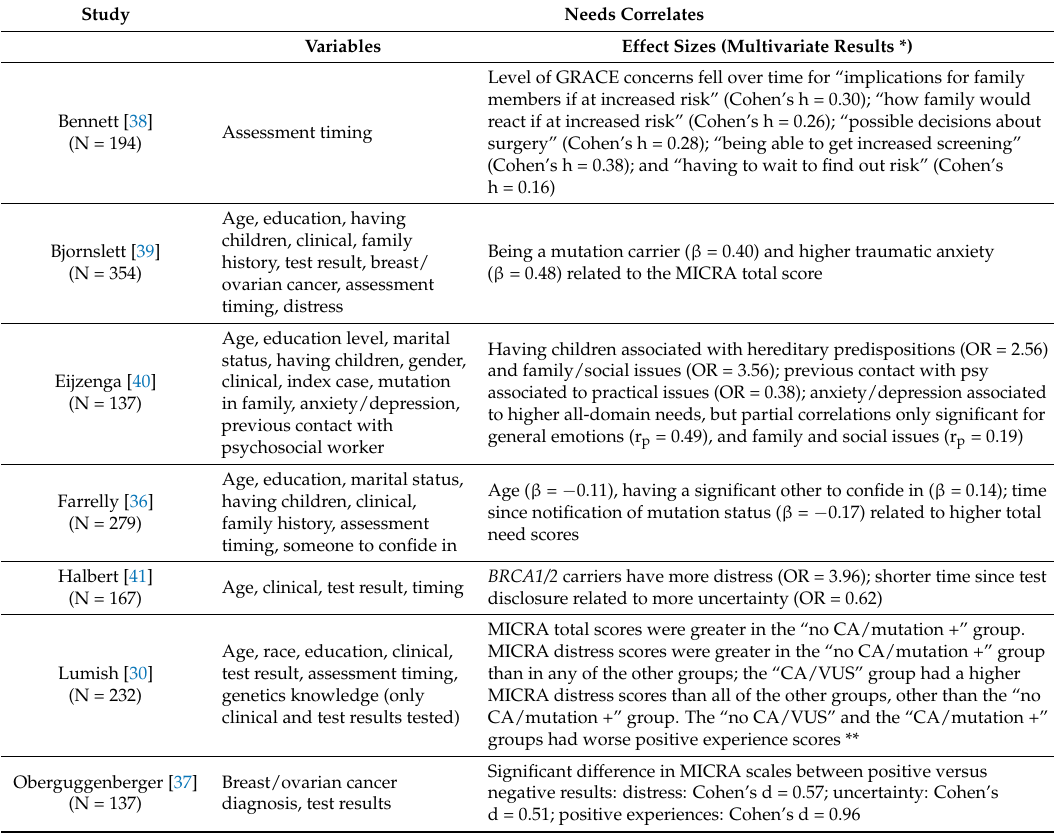
Table 5. Literature review: correlates of concerns, difficulties, needs, care preferences, and unmet